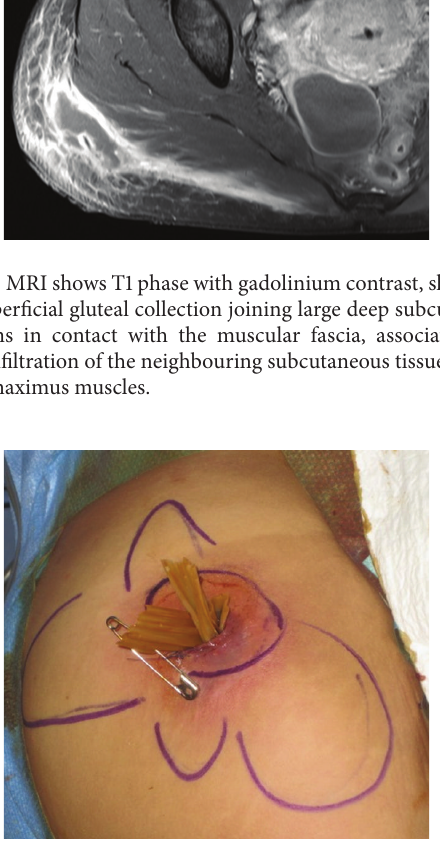
Figure 2: Intraoperative view after debridement of the gluteal collection and placement of drains in undermined areas (drawn in blue).